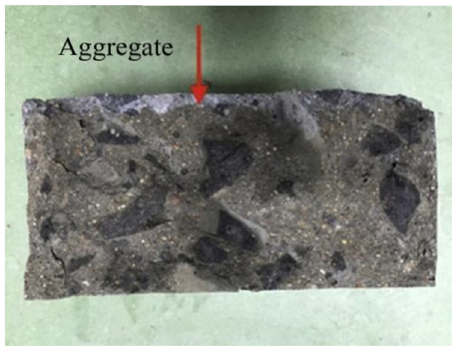
Figure 7: Aggregate diagram [ 68 ]